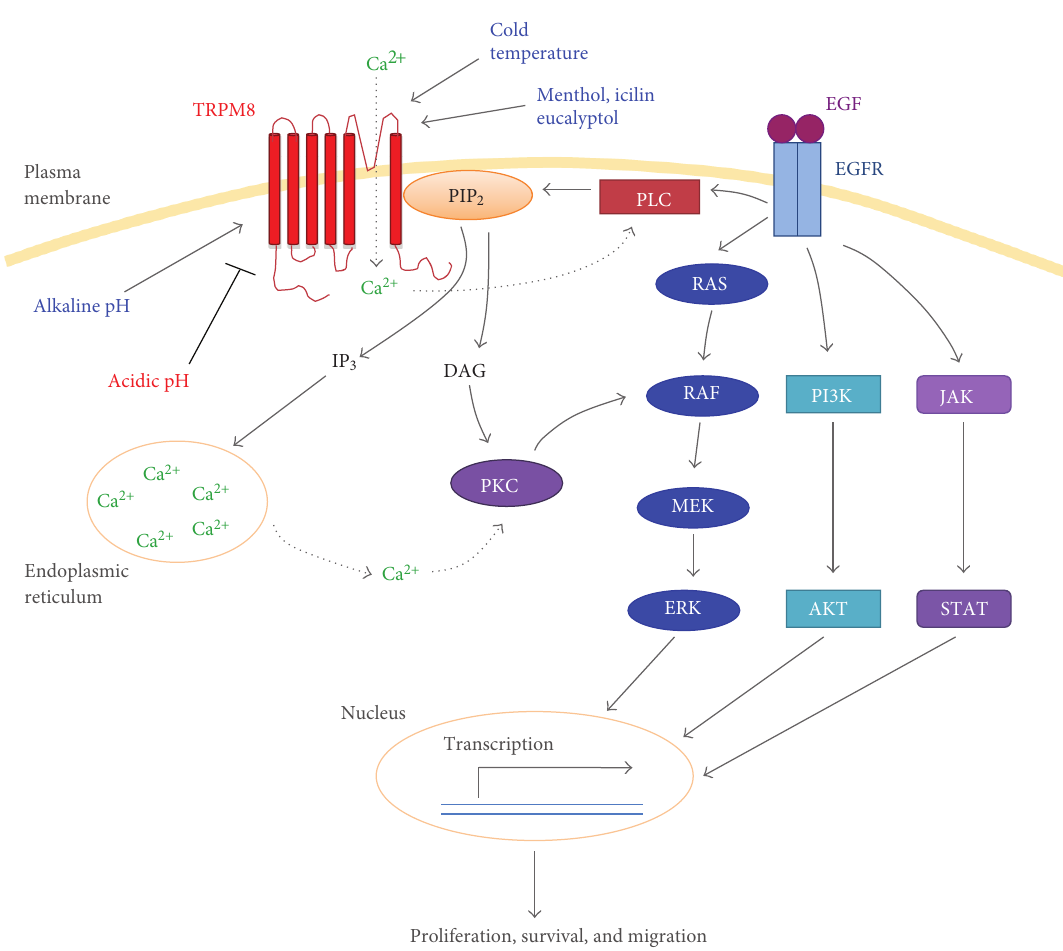
F 4: A working model for the proliferative, prosurvival, and migratory roles of TRPM8 in pancreatic adenocarcinoma cells. e ion channel activity of TRPM8 can be stimulated by cold temperature, menthol, alkaline pH, or phosphatidylinositol-4,5-bis-phosphate (PIP